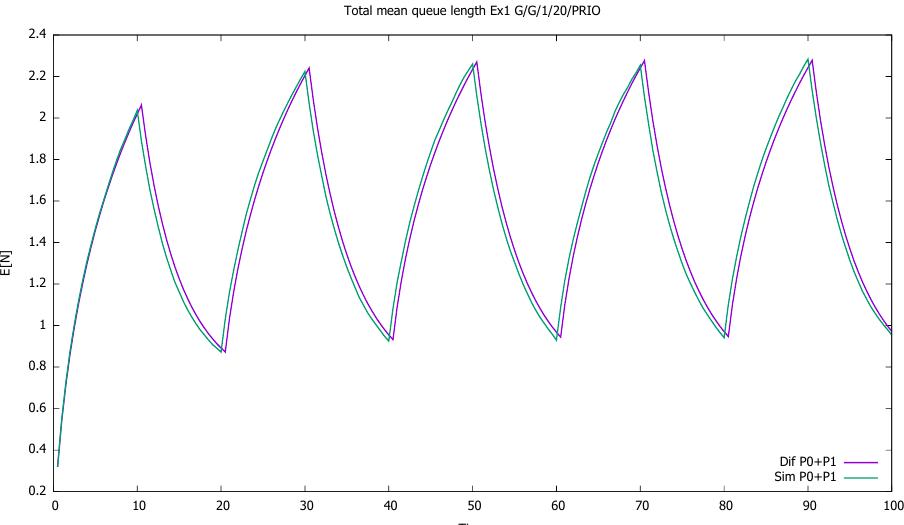
Figure 1. Section 3.1, low load: total mean queue length as a function of time for both classes (P0 + P1) taken